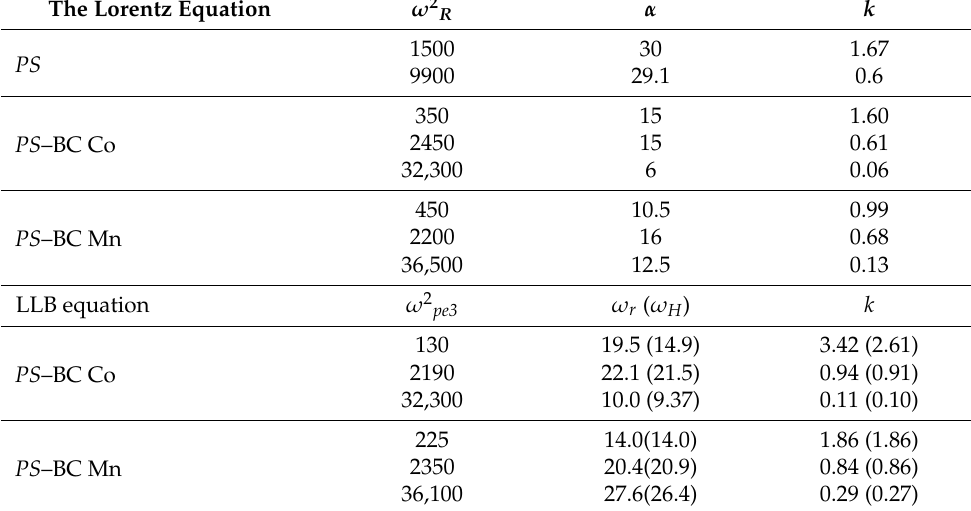
Table 1. Values of ω 2 R and α , as well as ω 2 pe3 and ω r ( ω H ) obtained for the approximation of absorption lines by the Lorentz method and by the LLB method. The definition of the coupling coefficient k between these values is given in the text (From [48] with permission). The Lorentz Equation ω 2 R α k 1500 30 1.67 PS